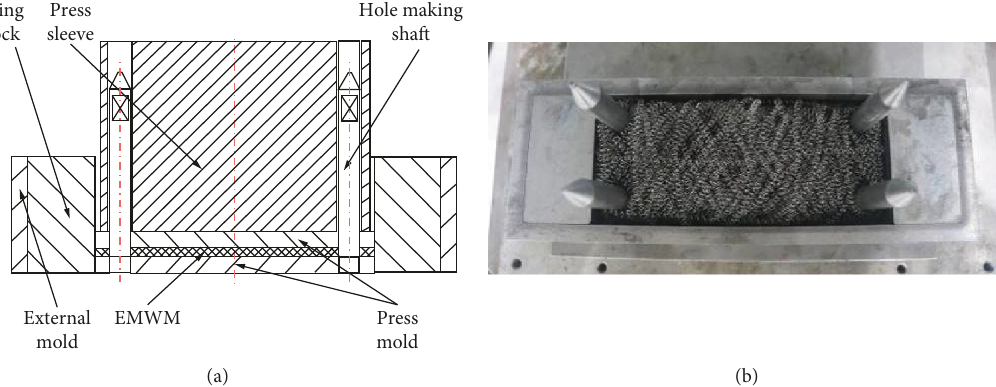
Figure 1: Mold and rough porous base material of EMWM. (a) Schematic diagram of the pressing mold. (b) Rough porous base material of EMWM.